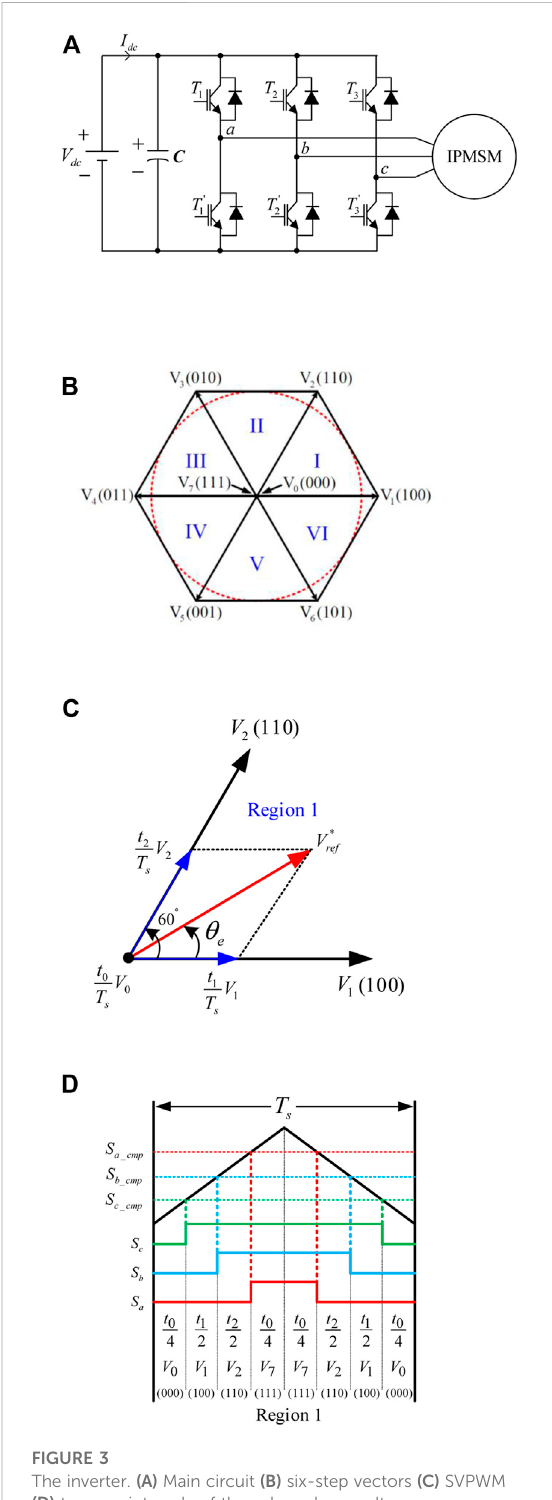
FIGURE 3 The inverter. (A) Main circuit (B) six-step vectors (C) SVPWM (D) turn-on intervals of the a-b-c phase